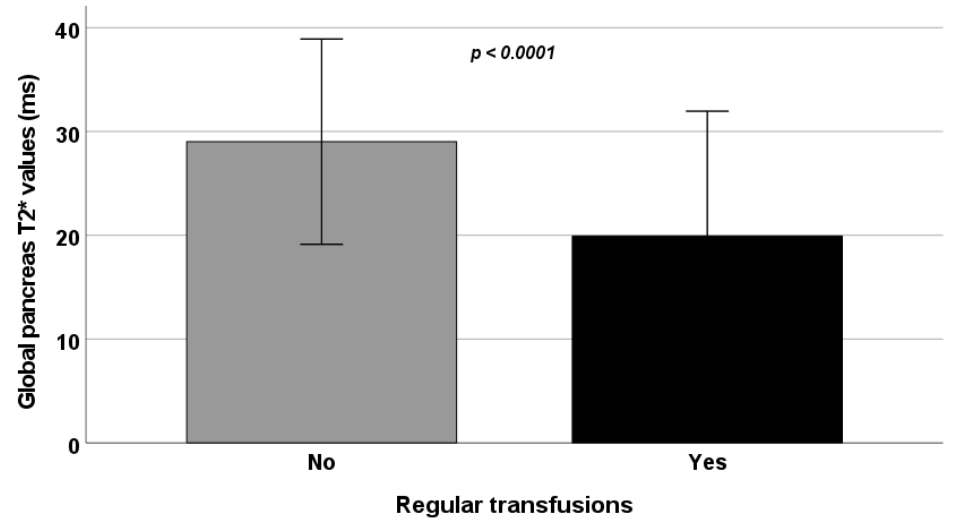
Figure 1. Comparison of global pancreas T2* values between NT-TI and RT-TI patients.